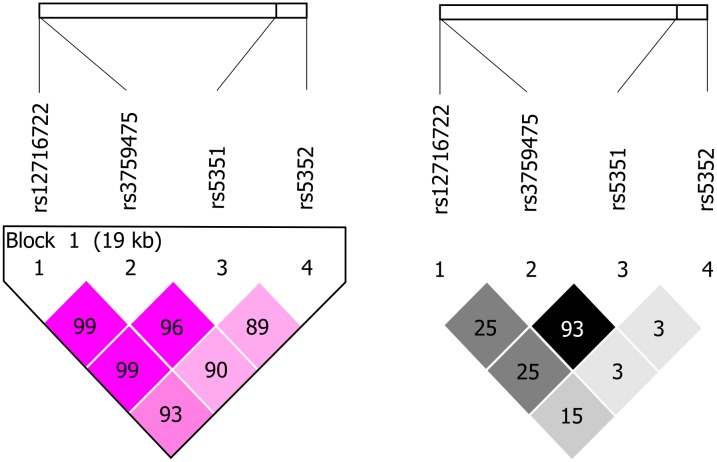
Linkage Disequilibrium (LD) plot of studied EDNRB SNPs. a) D´ b) R2.